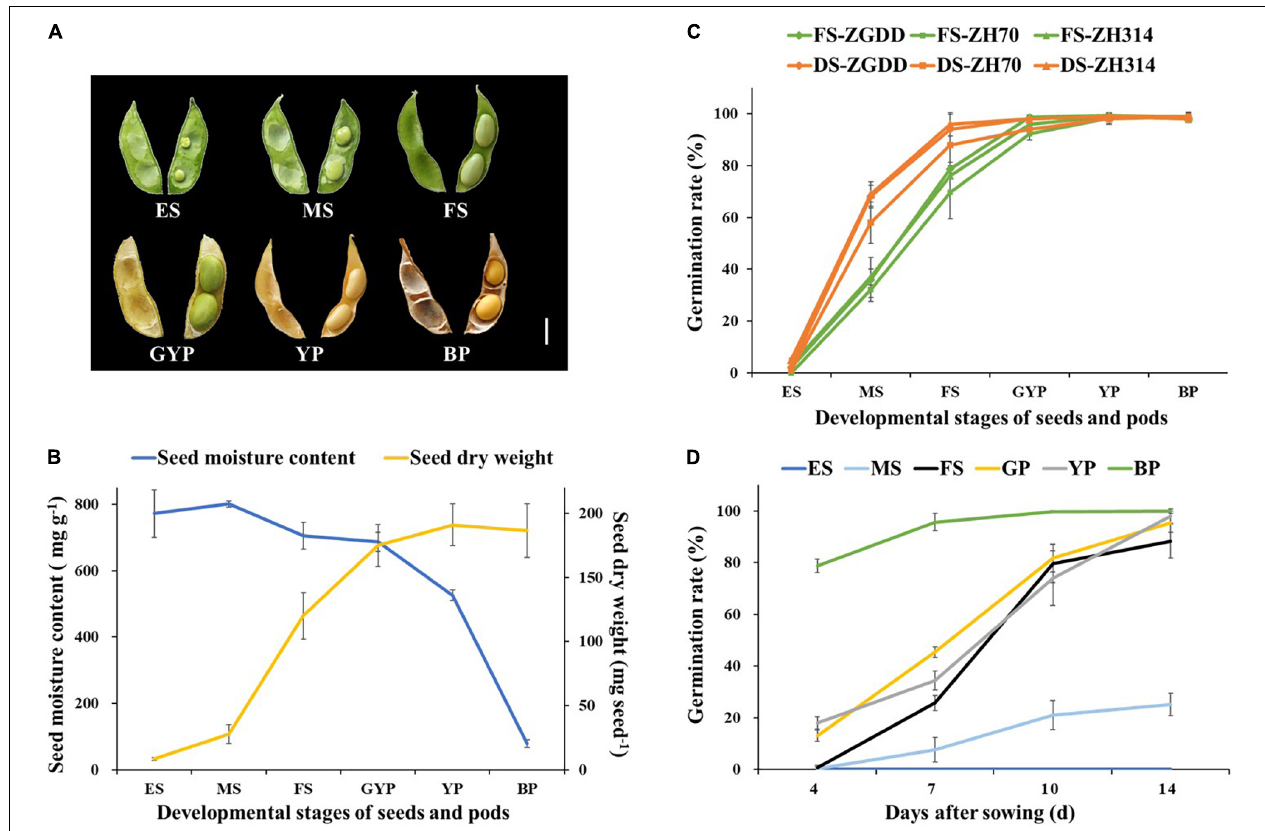
FIGURE 2 | The developmental status and the germination rate of seeds harvested at different reproductive stages. (A) Images of pods and seeds harvested at different reproductive stages. (B) The moisture content and dry weight of seeds harvested at different reproductive stages. (C) The comparison of germination rate between the freshly sown seeds (FS) after shelling and the desiccated seeds (DS). (D) The germination rate of the fresh seeds in different days after sowing. The seeds of soybean ( cv . Heihe27) were sown immediately after shelling. Developmental stages of seeds and pods: ES, early seed pod; MS, medium-seed pod;